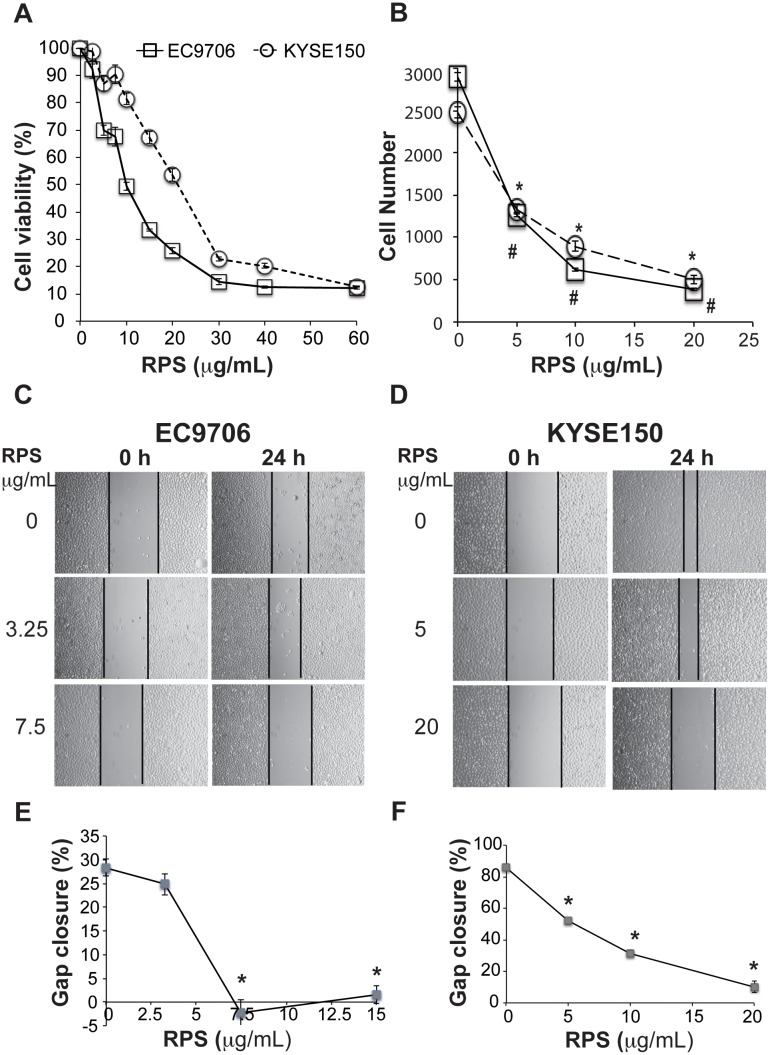
RPS inhibited the viability, migration, and invasion of esophageal cancer cells.
A. RPS inhibited the viability of esophageal cancer cells. After overnight incubation, cells in 96-well plates were treated with RPS at 0, 2.5, 5, 7.5, 10, 15, 20, 30, 40, or 60 μg/mL for 48 hours and then incubated with 20 μL of MTT (5mg/mL) for 4 hours. The absorbance at 550 nm was measured in a microplate reader. The percentage of viability relative to the controls without RPS was calculated. Each concentration was tested with 6 repeats in each experiment, n = 3. B. RPS reduced the invasion of esophageal cancer cells. Cells were cultured in the transwell chamber (5 x 104/chamber, 8 μm pore size and coated with 1mg/mL matrigel) containing serum-free media with RPS at 0, 5, 10, or 20 μg/mL in the upper chamber and RPMI-1640 medium + 10% FCS in the lower chambers for 48 h. The penetrated cells at the lower surface of the filter were fixed and counted under a microscope. A total of 5 fields of each chamber were randomly selected and the average cell number of the 5 fields was used, n = 3. * and # represents significant difference at 5, 10, and 20 μg/mL of RPS compared to 0 μg/mL of RPS in EC9706 cell and KYSE150 cells, respectively, P < 0.01. C. Images of wound healing of EC9706 cells, 20 x. D. Images of wound healing of KYSE150 cells, 20 x. E. RPS reduced the migration of EC9706 cells. F. RPS reduced the migration of KYSE150 cells. A total of 5 scratches were used for each concentration of RPS. Cells were cultured in serum-free media with RPS at 0, 3.25, 7.5, or 15 μg/mL for EC9706 cells, or at 0, 5, 10, or 20 μg/mL for KYSE150 for 24 h. Wounds were photographed under a phase-contrast inverted microscope, and the percentage gap closure was calculated as (width at 0h –width at 24 n)/width at 0h * 100%, n = 3. * represents significant difference between RPS at specified concentration vs 0 μg/mL, P < 0.01.